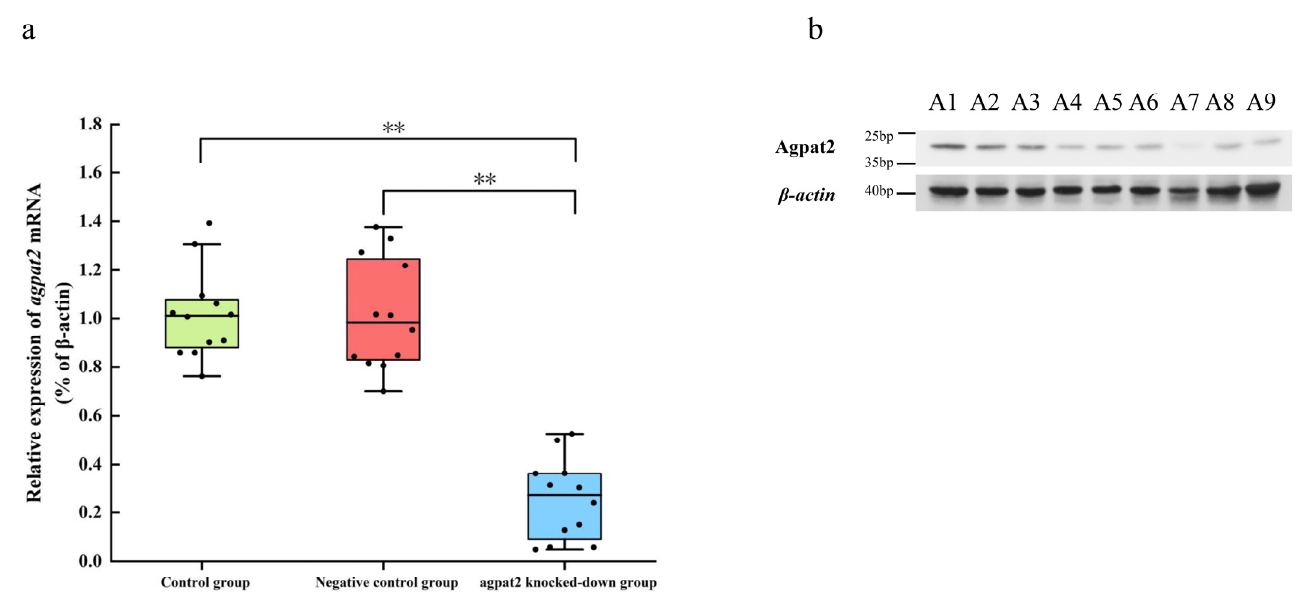
Figure 3. Downregulation of AGPAT2 transcript levels and AGPAT2 protein levels in Nile tilapia liver tissue by antisense RNA technology. ( a ) Transcript levels of AGPAT2 in liver tissues of the AGPAT2 knock-down, control, and negative control groups as determined by qRT-PCR (mean ± SE, n = 12 replicates per group). ** indicates significant difference ( p < 0.05); ( b ) representative images of Western blots showing an abundance of AGPAT2 protein in liver tissues of the control and AGPAT2 knock-down groups: A1–A2, control; A3, negative control; A4–A9, AGPAT2 knock-down. The β -actin/ β -actin was used as the reference gene transcript/protein.